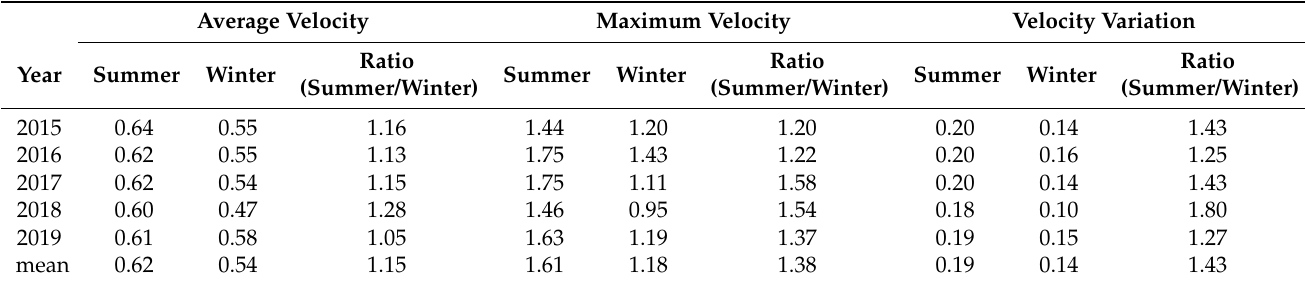
Table 2. Average sea surface velocity, maximum sea surface velocity, and variation in summer and winter (unit: m/s). Average